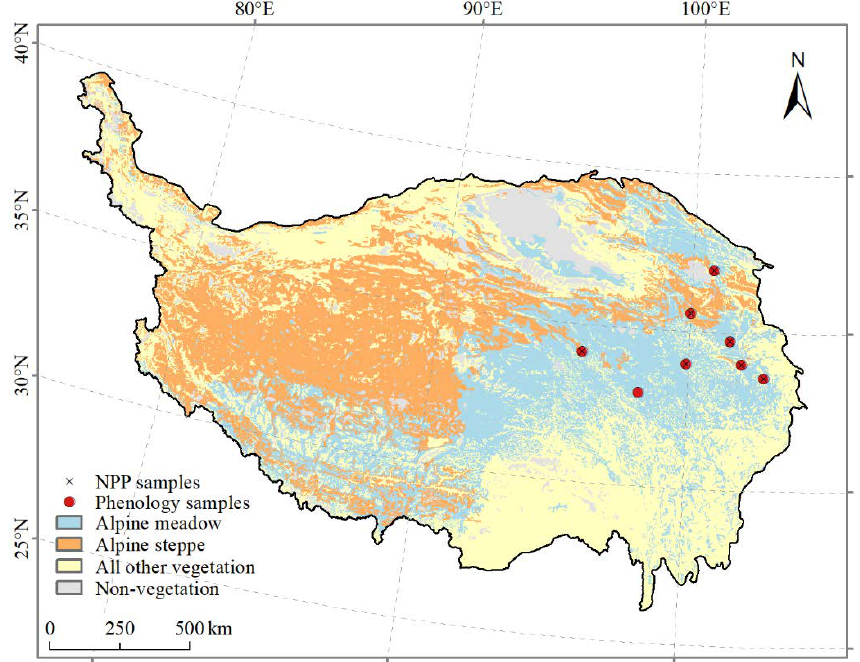
Figure 1. Spatial distribution of the biomes, net primary productivity (NPP) and grassland phenology sampling sites on the Tibetan Plateau.